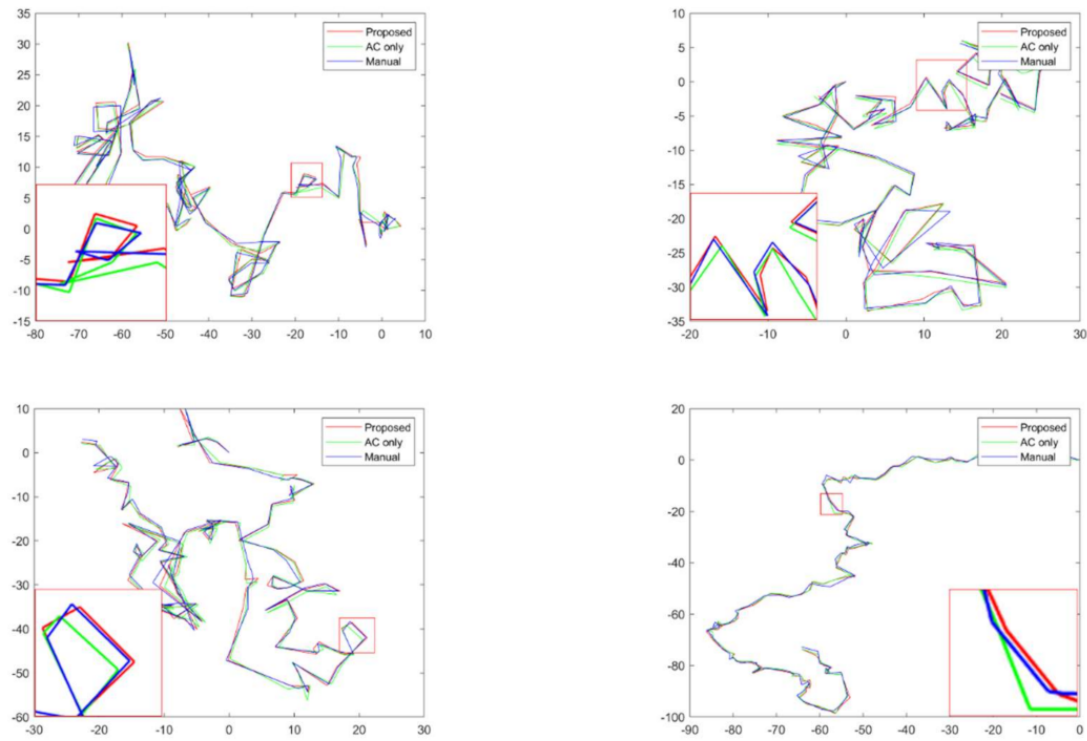
Figure 7. Trajectories of four cells. Each coordinate was represented by normalizing with respect to the starting point. The red line represents the proposed method, the green line represents the method that uses active contour only, and the blue line represents the results tracked